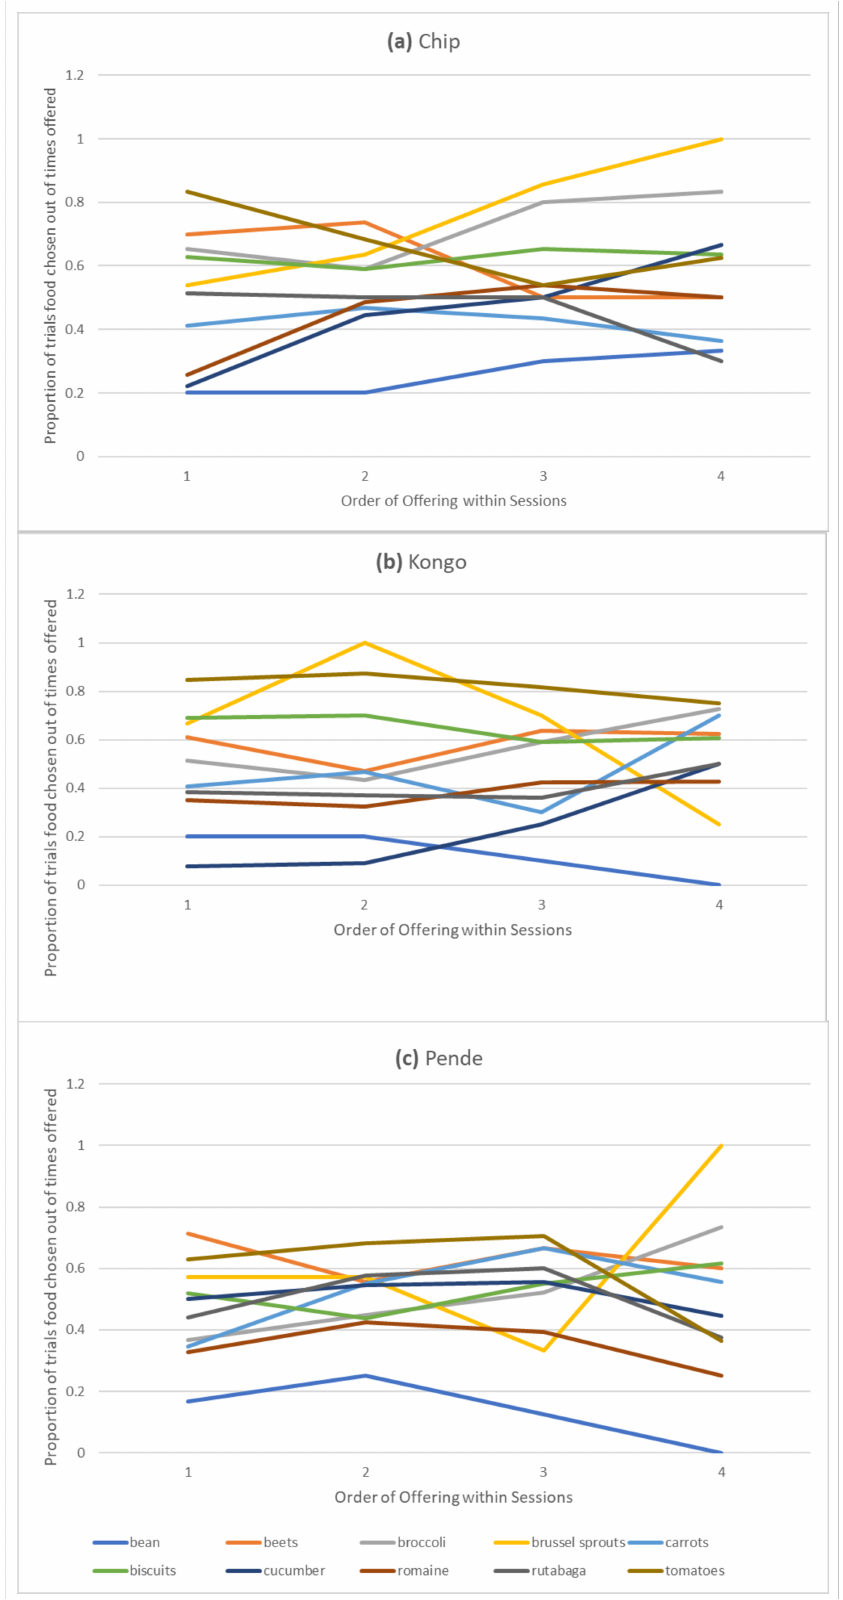
Figure 5. Proportion of choices of each food type across trials in which that food is offered within sessions for each